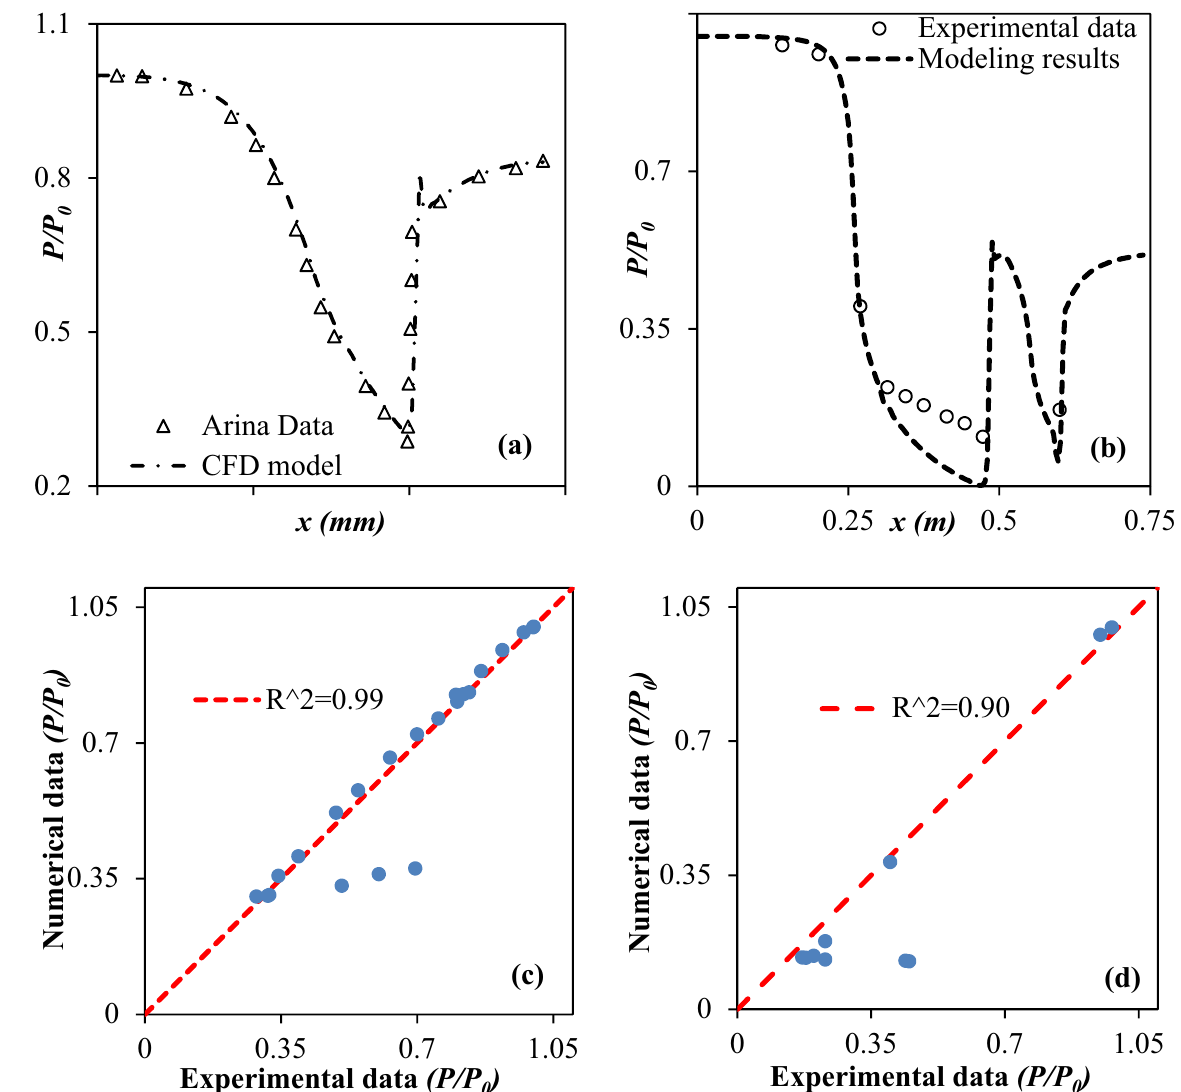
Figure 5. Validation of the developed CFD model: ( a , b ) numerical results versus experimental data, ( c , d ) error analysis by root-mean-square (R 2